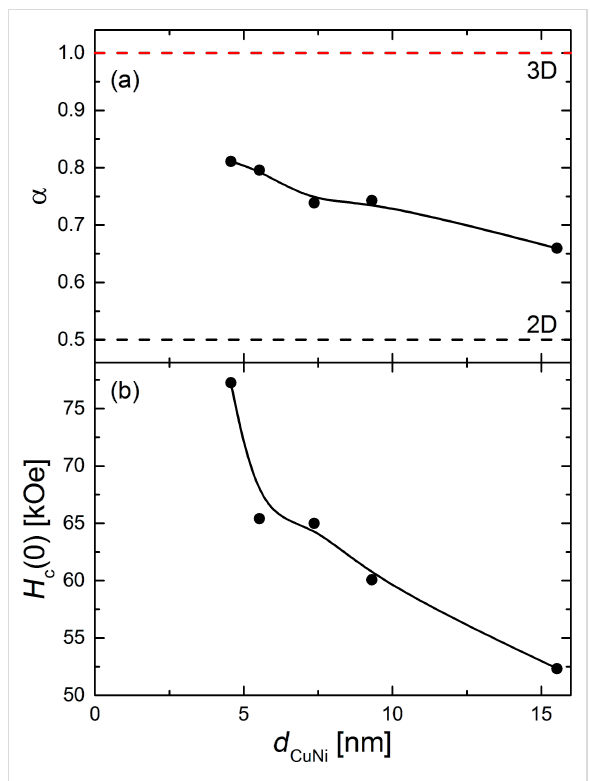
Figure 7: (a) Dimensionality parameter α and (b) the (fictive) upper critical field at zero temperature, H c (0), as obtained by fitting Equation 2 to the experimental data, as a function of the thickness of the Cu 41 Ni 59 layer. The solid lines are guide to the eye, the dashed ones in (a) indicate the values of α for a two and a three-dimensional superconductor according to the GL-theory, respectively.